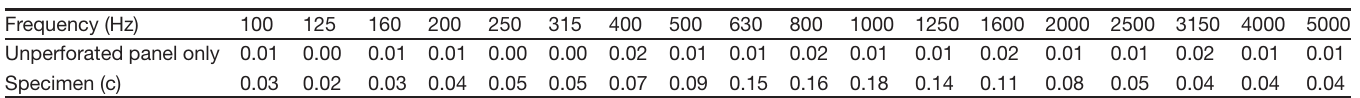
Table A1. Equivalent sound absorption area of Specimen (c) in comparison with a partition with unperforated panels only Frequency (Hz) 100 125 160 200 250 630 1000 1250 1600 2000 2500 3150 4000 5000 Unperforated panel only 0.01 0.00 Specimen